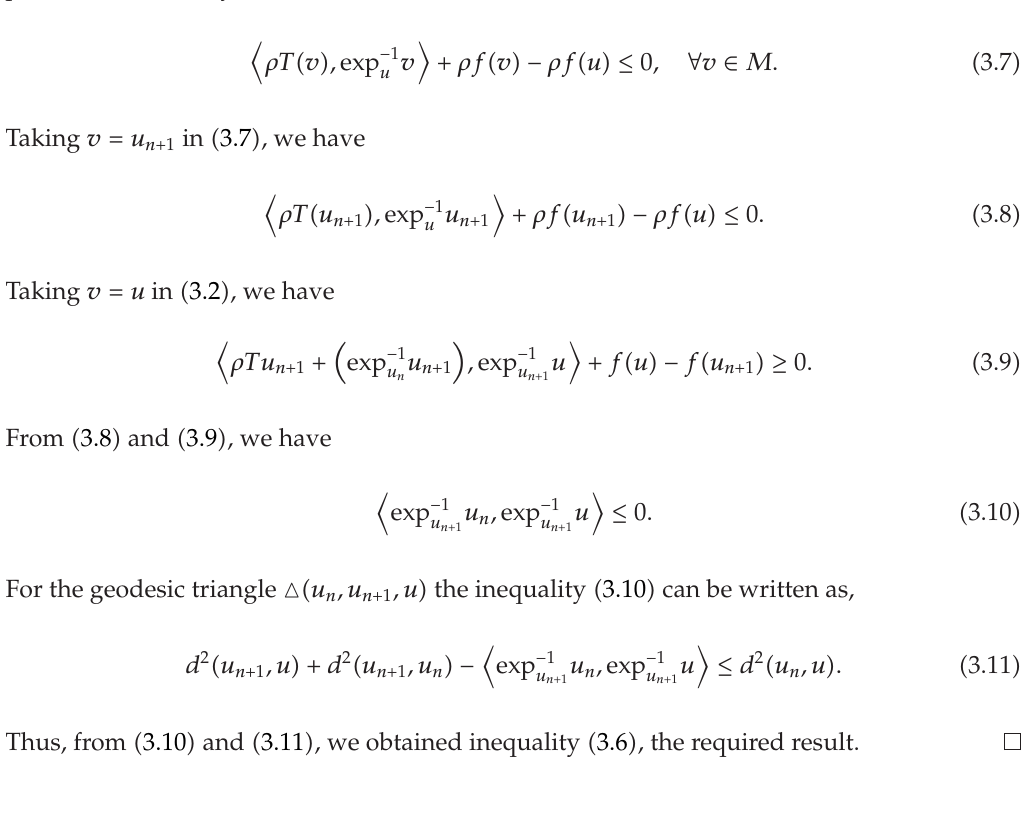
Algorithm 3.4. For a given u 0 ∈ M , compute the approximate solution by the iterative